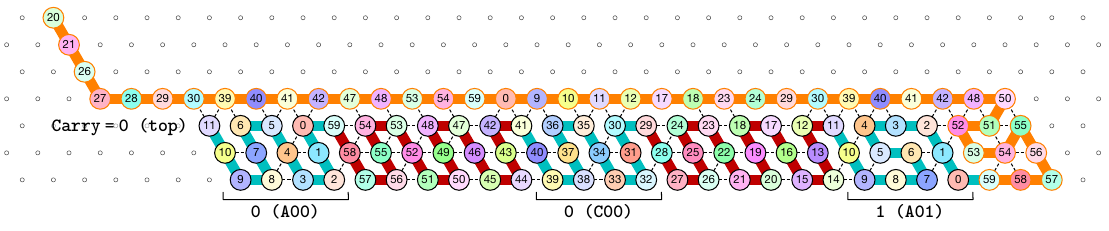
Figure 7. The folding of the central part of the first zig pass in the 3-bits counter.